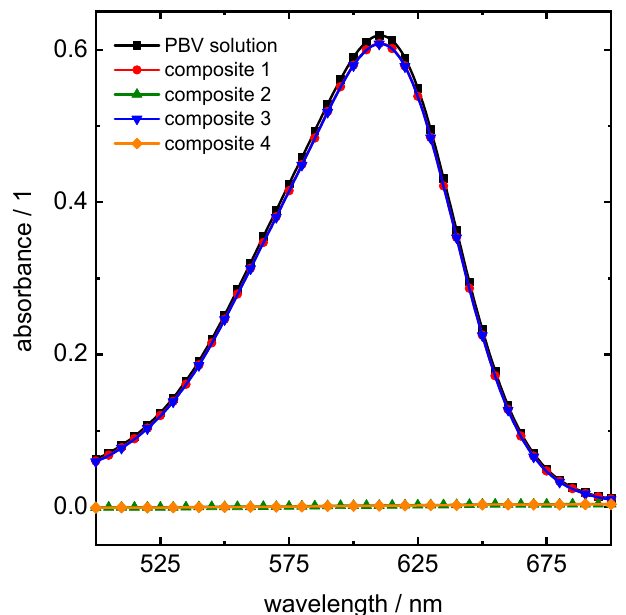
Figure 7. Water purification with magPOM-SILP composites: UV-Vis absorption spectra of Patent Blue V (PBV) (black) with reference composites 1 and 3 (red and blue) and magPOM-SILP composites 2 and 4 (green and orange), which show total removement of PBV from solution, through 0.0 adsorption of irradiated light.